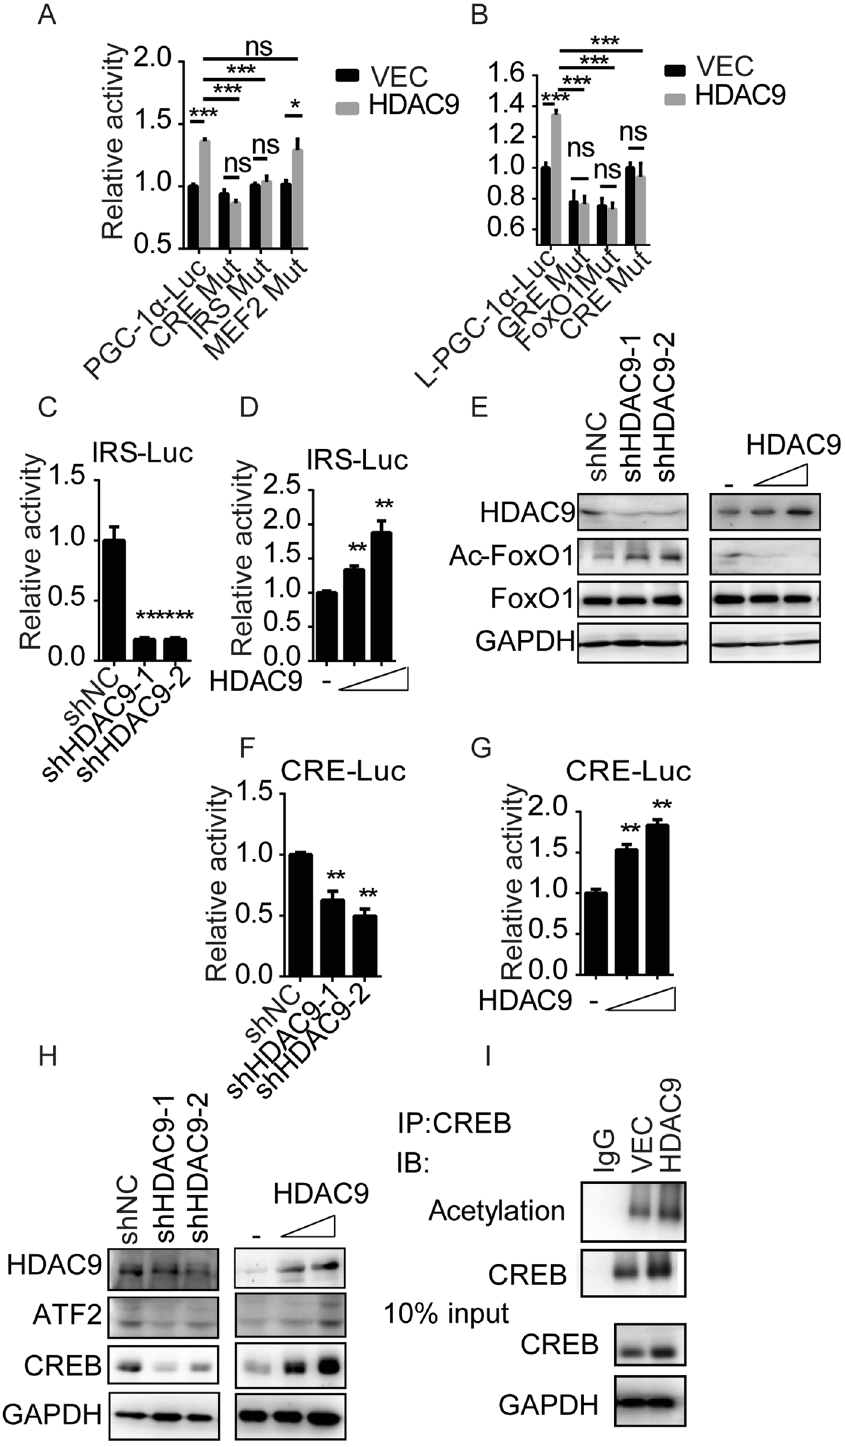
Figure 4. Deacetylation of FoxO1 and upregulation of CREB by HDAC9-induced PGC-1 α promoter activity. Different PGC-1 α ( A ) and L-PGC-1 α ( B ) promoter mutant activities in HDAC9-overexpressing cells, as detected using luciferase reporter assay. IRE-Luc activity was detected following HDAC9 depletion ( C ) or by dose response upon HDAC9 induction ( D ). ( E ) The proteins indicated in ( C ) or ( D ) were analysed. CRE-Luc activity induced by HDAC9 depletion ( F ) or dose response following HDAC9 induction ( G ). ( H ) The proteins indicated in ( F ) or ( G ) were analysed. ( I ) Endogenous CREB (right panel) was immunoprecipitated from the indicated cell lysates and immunoblotted with antibodies against CREB and acetylated lysine. Data are represented as the mean ± SEM for triplicate